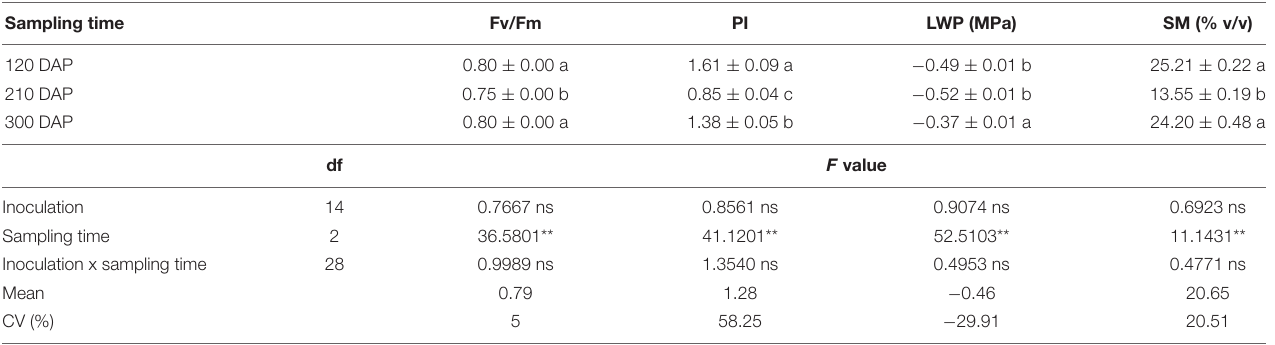
TABLE 1 | Means ( ± standard error) of PSII (Fv/Fm), performance index (PI), leaf water potential (LWP) and soil moisture (SM) of cassava at different times (120, 210 and 300 DAP) in Experiment 1 and the results of a repeated measures analysis on these variables to test for a sampling time effect.